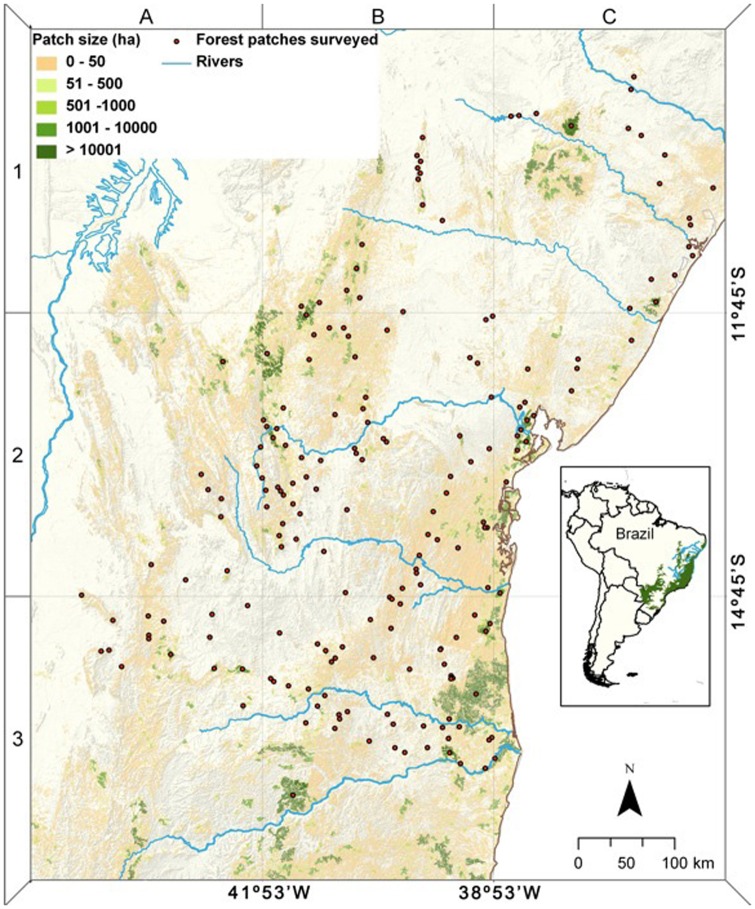
Distribution of remaining forest patches across the northern Atlantic Forest study region showing all surveyed forest patches.For detailed maps see Fig. S1, S2, S3.